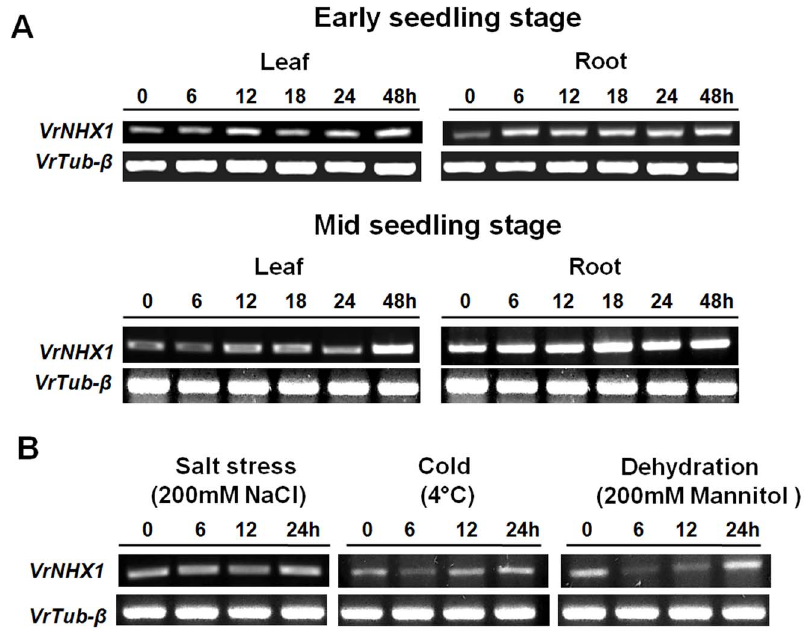
Figure 7. Expression analysis of VrNHX1 in early and mid stage mungbean seedlings under various abiotic stresses. (A) Semi- quantitative RT-PCR for studying expression patterns of VrNHX1 under salt stress was performed. Total RNA was isolated from leaves and roots of early (5 days) and mid stage mungbean seedlings (10 days) under 200 mM NaCl treatment at time intervals of 0, 6, 12, 18, 24, and 48 hrs. (B) Semi- quantitative RT-PCR for studying expression patterns of VrNHX1 under different abiotic stress conditions such as salt, cold and dehydration stress was studied. Total RNA was isolated from mid stage mungbean seedlings under (A) 200 mM NaCl, (B) Cold (4 u C), and (C) 200 mM Mannitol treatment at time intervals of 0, 6, 12, and 24 hrs. PCR fragments of 566 bp and 422 bp size corresponding to VrNHX1 and VrTub b were fractionated electrophoretically on 2% agarose gel stained with 10 mg/ml ethidium bromide.